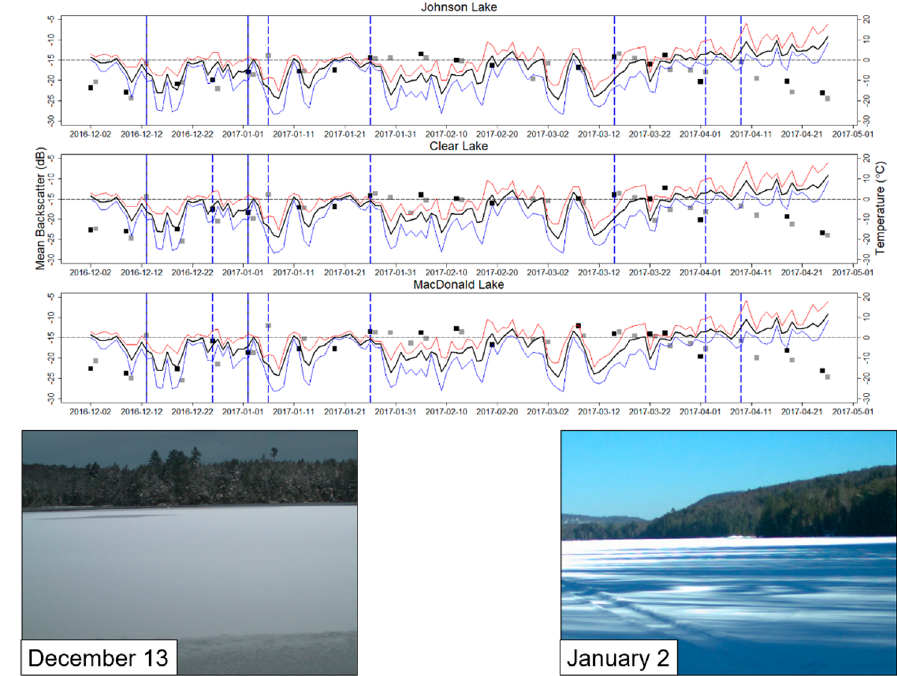
Figure 8. Backscatter and temperature evolution for the 2016/2017 ice season. Black squares represent images that were acquired in the PM and grey squares represent images acquired in the AM. The blue lines indicate when a major freezing event was determined and the solid lines are the dates of the sample images. The 13 December image illustrates the initial conditions captured by RADARSAT-2 and the 2 January images illustrates full ice cover on the lake following melting on 27 December. The 13 December photo was acquired from MacDonald Lake and the 2 January photo was acquired from Clear Lake.